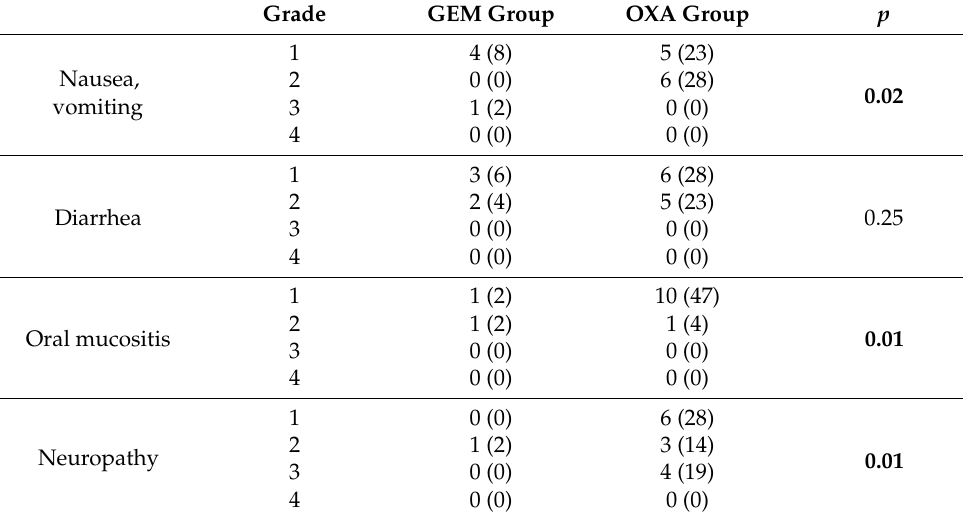
Table 4. Treatment toxicity according to the chemotherapy group.